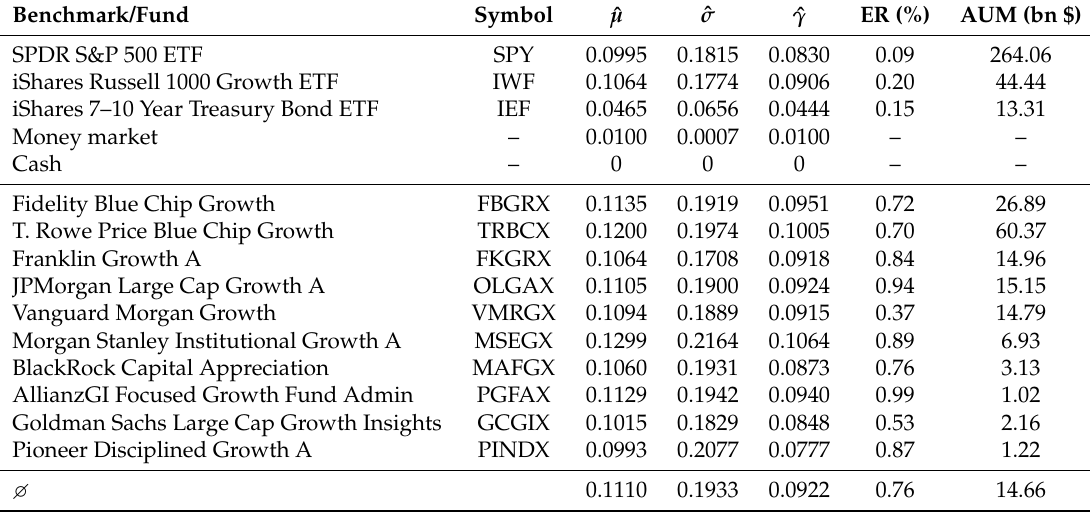
Table 1. Basic characteristics of the benchmarks and funds that are taken into consideration, i.e., the estimated drift coefficients ( ˆ µ ), diffusion coefficients (ˆ σ ), growth rates ( ˆ γ ) as well as their expense ratios (ER) and assets under management